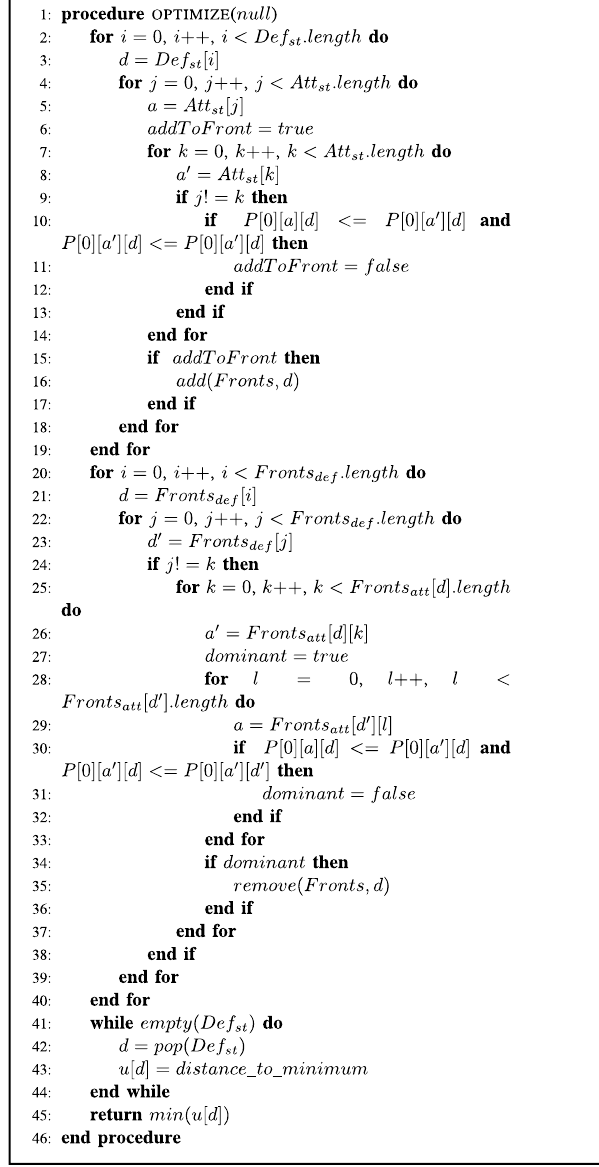
Figure 4. Pseudocode for Pareto Optimization